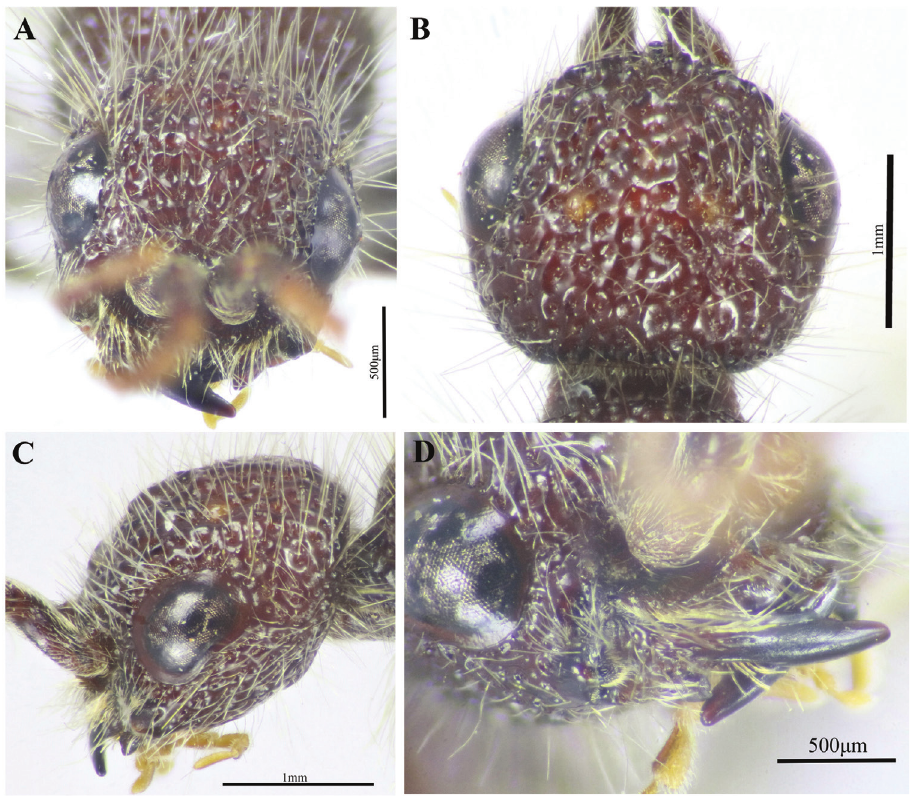
Figure 19. Pseudophotopsis mascatiana Invrea (Female) A–C head, frontal, dorsal and lateral views, re- spectively D mandible, fronto-lateral